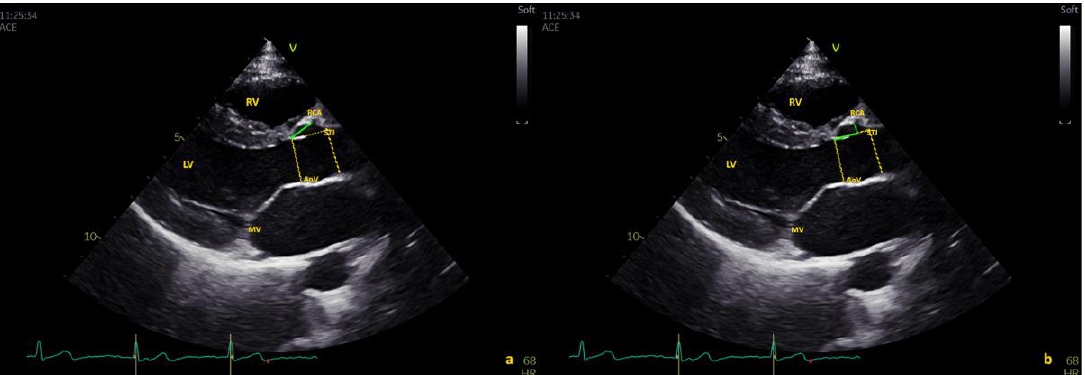
Figure 1. Measurement of right coronary artery (RCA) origin in long-axis view. ( a ) Coronary artery origin height measured using the oblique distance between the aortic annulus and proximal aspect of the coronary artery ( a ). The distance from the aortic annulus to the sinotubular junction (STJ) was measured, and the coronary artery height measurement was repeated on this horizontal line, tracing the perpendicular from the origin of the coronary ostium ( b ). LV = left ventricle, MV = mitral valve, RV = right ventricle, Aov =Aortic valve.